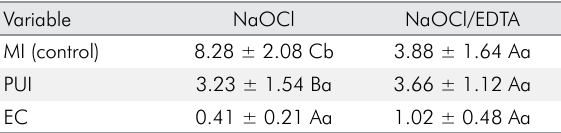
Table 1. The mean ± standard deviation values of residual filling material (%) for each PSI subgroup, regardless of the third level.